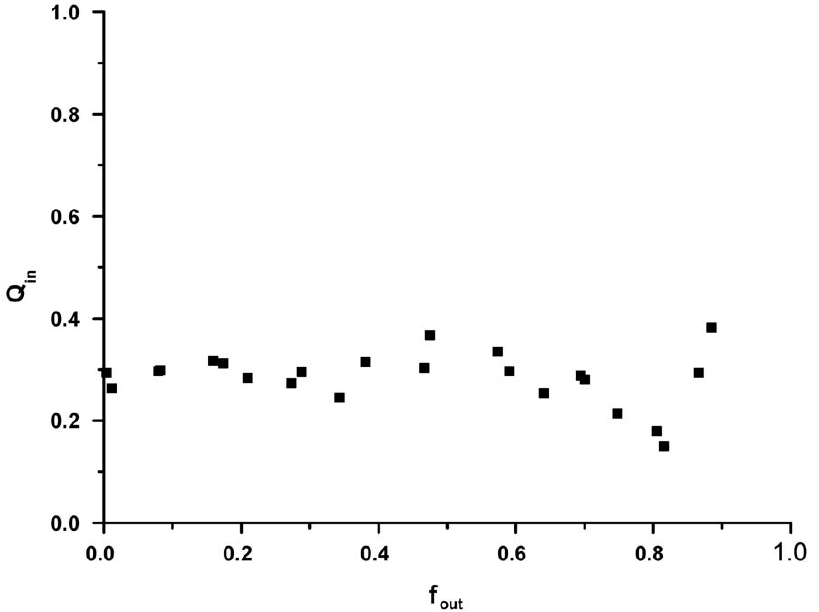
Figure 4. Fluorescence quenching assay results. POPG LUVs encapsulating HPTS/DPX were mixed with different amounts of oligomeric a S to a final lipid concentration of 25 m M. The quenching ratio Q in in the vesicle interior does not change as a function of the amount of escaped dye f out , which indicates that dye efflux from the LUVs occurs through an all-or-none mechanism.